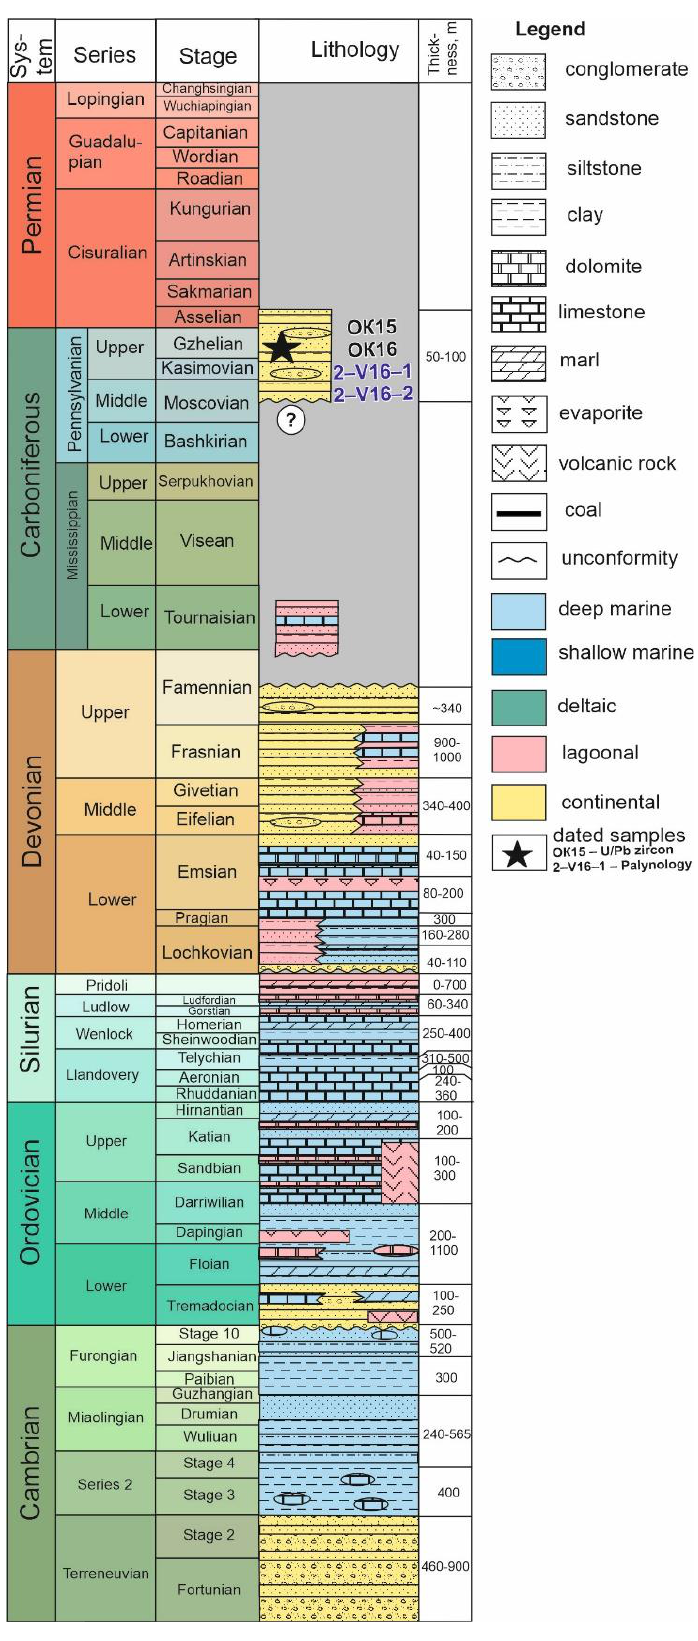
Figure 2. Simplified stratigraphic column of the Paleozoic strata of Severnaya Zemlya archipelago (modified after [12]).